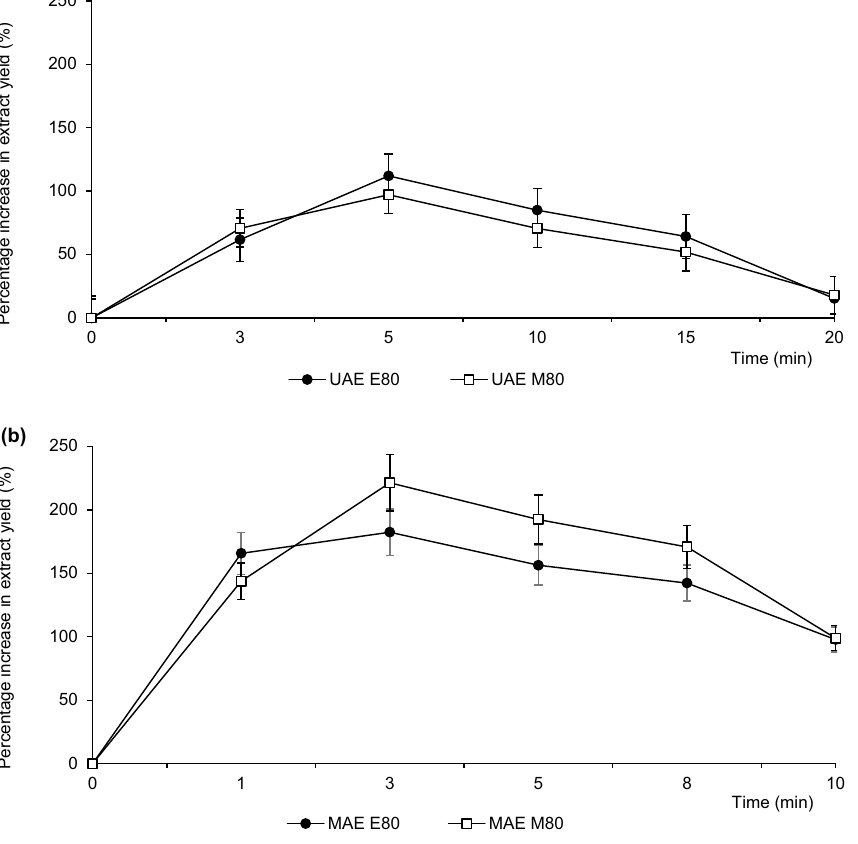
Figure 3. Effect of extraction time on the changes in yields of phenolic acids; ( a ) UAE, ( b )